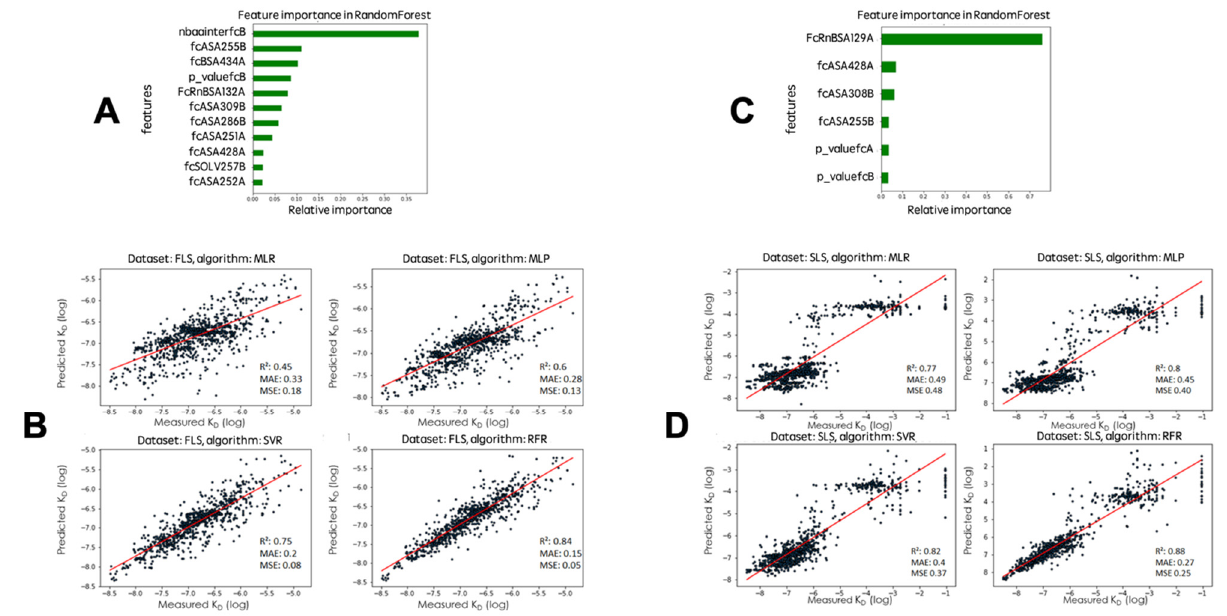
Figure 1. Parameter selection and machine learning performance; parameters are defined in Table A1. ( A ) Impact of the features in the FLS model. ( B ) Scatterplots of the 10-fold cross-validation predictions with the 4 algorithms trained on FLS. ( C ) Impact of the features in the SLS model. ( D ) Scatterplots of the 10-fold cross-validation predictions with the 4 algorithms trained on SLS. The scatterplots show the experimental (X axis) vs predicted (Y axis) affinities of the variants. Regression line is in red; R²: coefficient of determination; MAE: mean absolute error; MSE: mean squared error; the features kept for the models have been evaluated with the “SelectFromModel” of sickit ‐ learn.